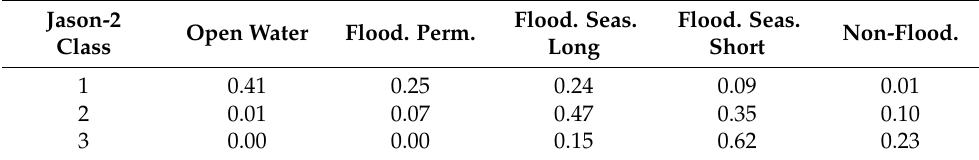
Table A3. Confusion matrix between 3 classes of RA backscattering coefficients from Jason-2 and the 5 land type classes identified on the study sites.